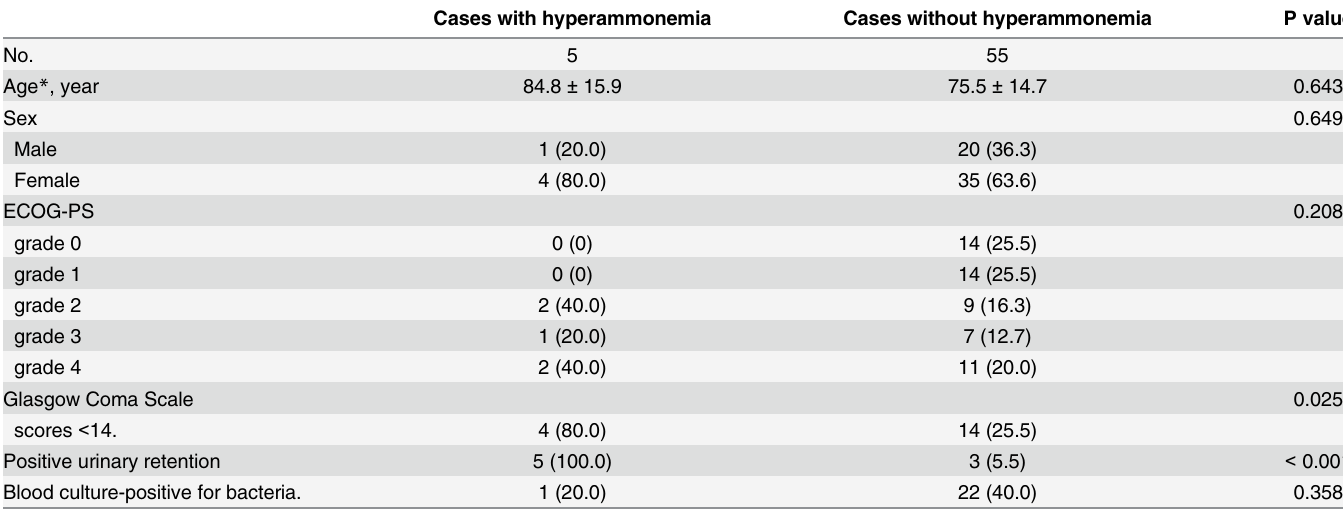
Table 2. Demographic characteristics of the subjects.